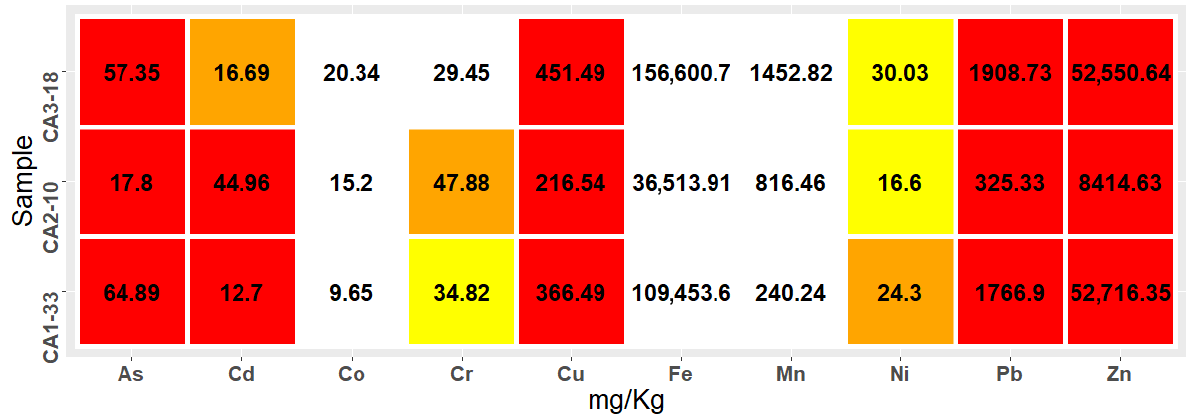
Figure 4. Heat map of the concentrations of the extractable forms of the metallic elements (by aqua regia digestion; evaluation of the degree of contamination) of the samples used in the laboratory assay. Color label: red—above the critical content; orange—caution content; yellow—content above the quality limits for soils [53] and sediments [54].